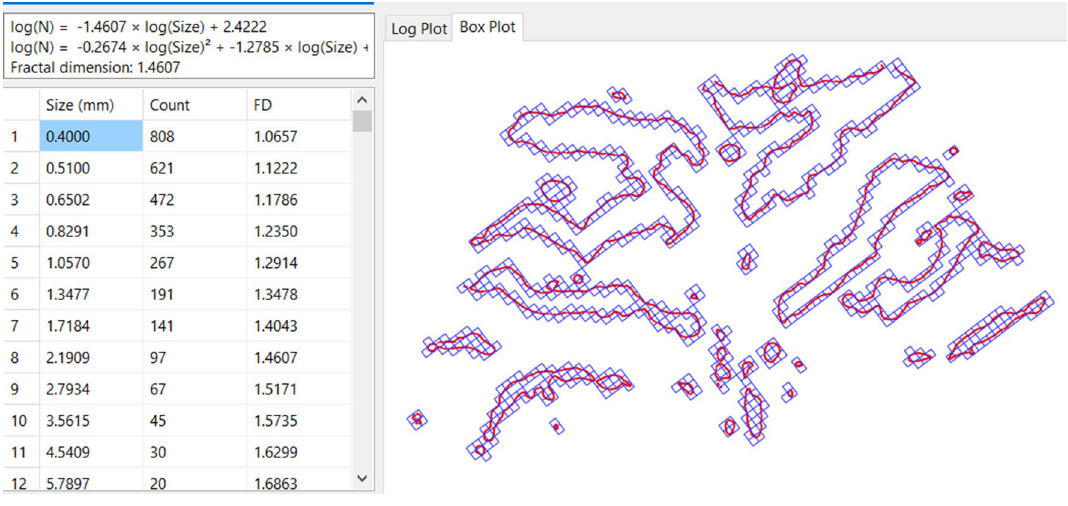
Figure 2. Box-counting fractal dimension